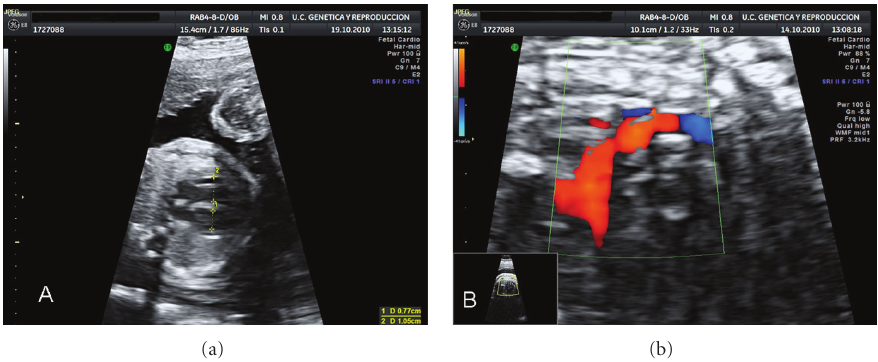
Figure 1: (a) Ultrasound showing chamber asymmetry. Lower: right ventricle (1.05cm); upper: left ventricle (0.77 cm). (b) Aortic coarc- tation. Arrow: aortic